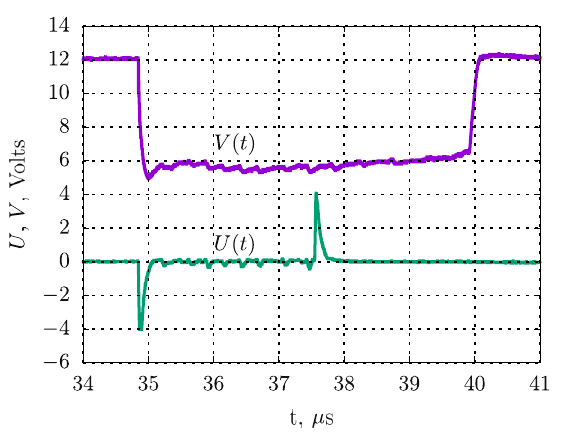
Figure 5. Cell voltage V ( t ) and gauge signal U ( t ) for BTF charge of 1.1 g/cm 3